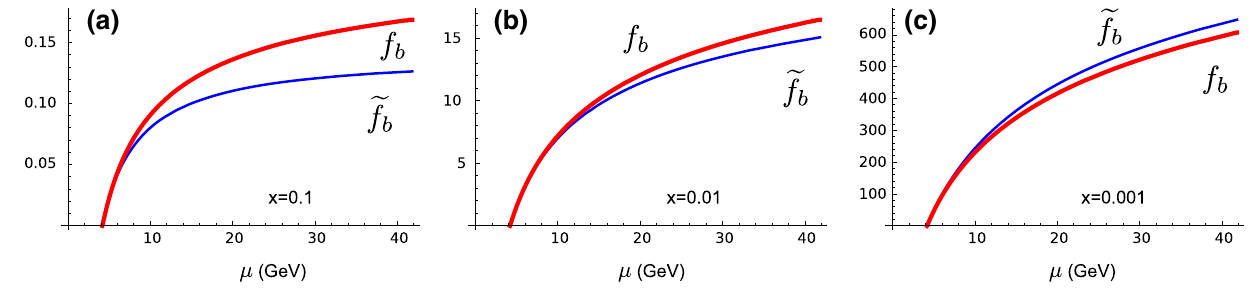
Fig. 2 The comparison of the DGLAP evolved PDF f b ( x ,μ) and the perturbatively calculated (cid:11) f b ( x ,μ) as a function of μ for selected x values. For μ → m b we find the functions match precisely: (cid:11) f b ( x ,μ) → f b ( x ,μ) . We have used NNPDF30_lo_as_118_nf_6 as the base PDF